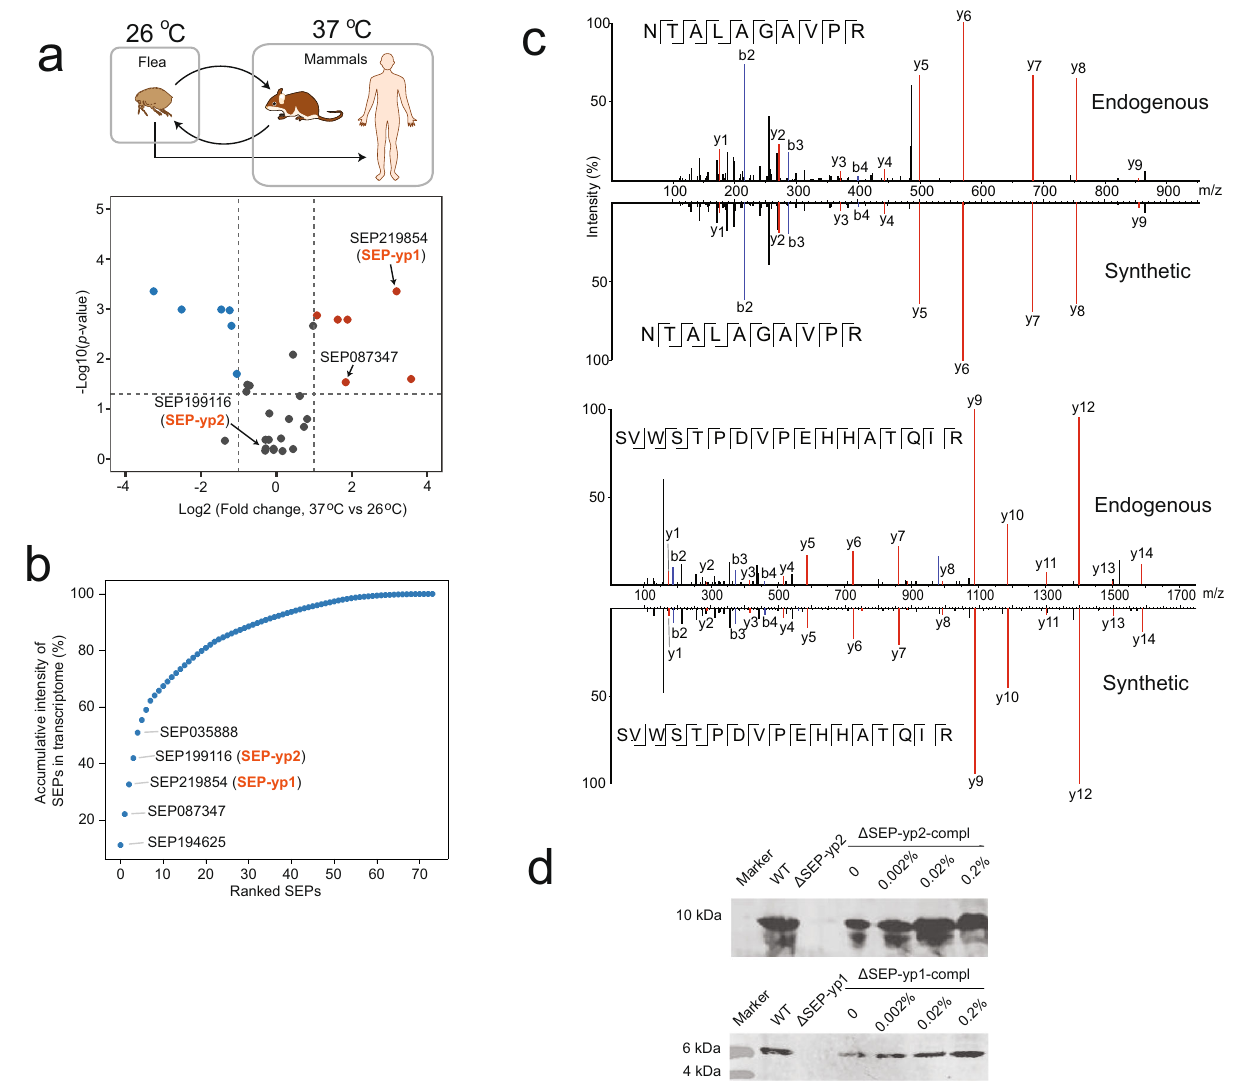
Fig. 3 Functional screening and molecular validation of the identi fi ed SEPs. a Quantitative peptidomics analysis of SEPs between two in vitro conditions mimicking the fl ea vector and rodents ’ temperatures. The upper panel shows the transmission of bacteria between fl ea and mammal hosts as well as the in vitro experimental conditions. The lower panel displays a volcano plot of quantitative results of SEPs between the two conditions. The p value was calculated by unpaired t test and adjusted with Benjamini – Hochberg procedure. Refer to Supplementary Data 4 for details. b Accumulative intensity of the ranked 76 identi fi ed SEPs in the transcriptome. The top fi ve most abundance of SEPs are labeled in the panel. Refer to Supplementary Data 4 for details. c Mirror plot showing the tandem mass spectra of endogenous and synthetic peptides, respectively, from SEP-yp1 (top panel) and SEP-yp2 (bottom panel). The b and y ions are, respectively, labeled with blue and red. d Western blotting of SEP-yp2 and SEP-yp1 showing bacterial lysis of Y. pestis WT, Δ SEP and Δ SEP-compl. Arabinose was added in the Δ SEP-compl strains at the concentrations of 0, 0.02, 0.2, and 2% to induce the expression of